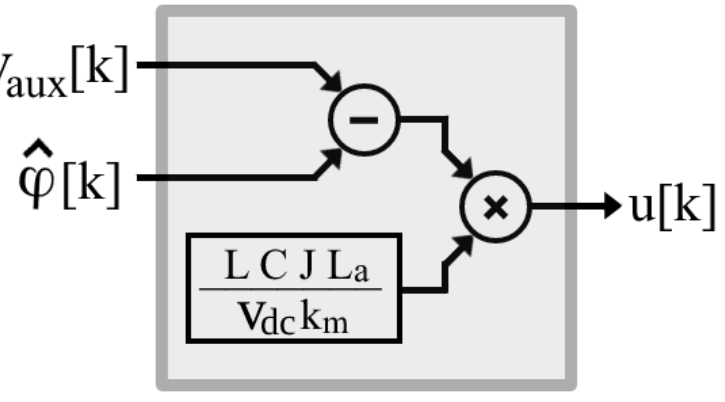
Figure 13. Implementation of the final linear control law module.